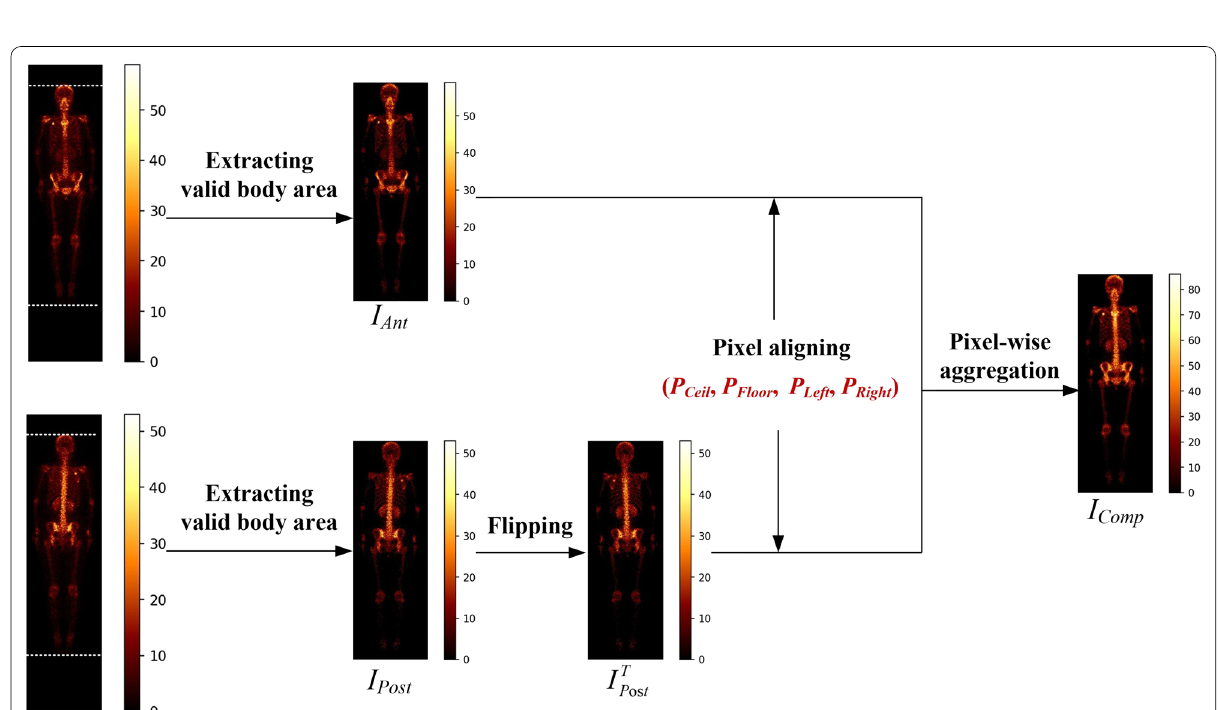
Fig. 2 Illustration of view aggregation for enhancing metastatic